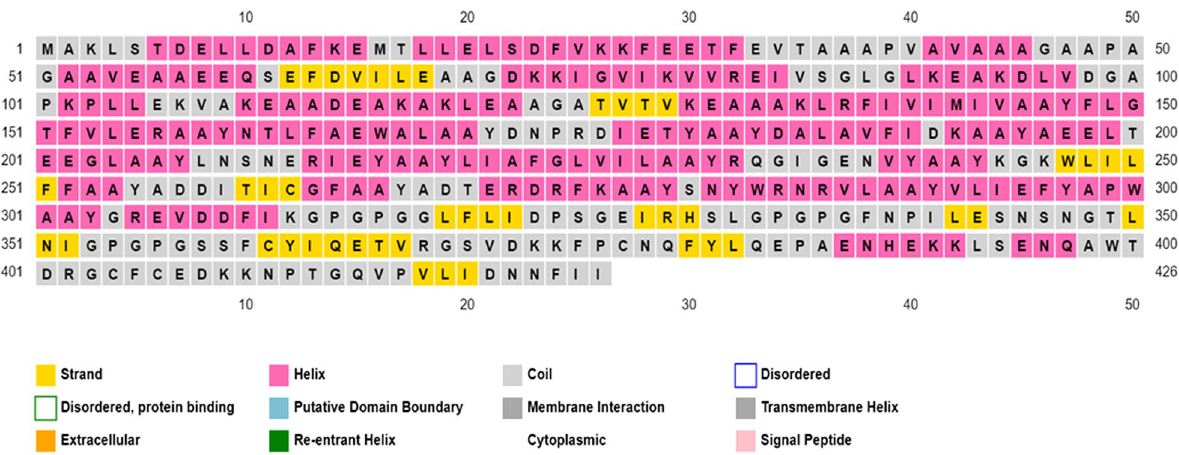
Fig. 4 Secondary structural predictions of the vaccine sequence